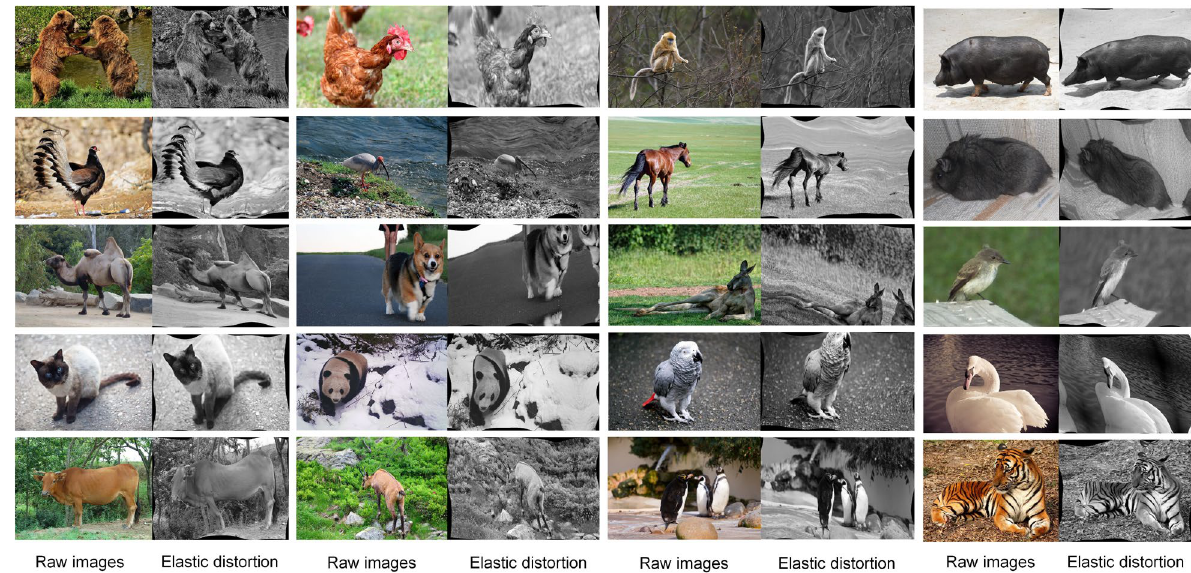
Figure 4. Example comparison of the EAOD dataset after elastic distortion. Each target was appropriately distorted without distorting the image. In this way, the diversity of target poses was enriched.